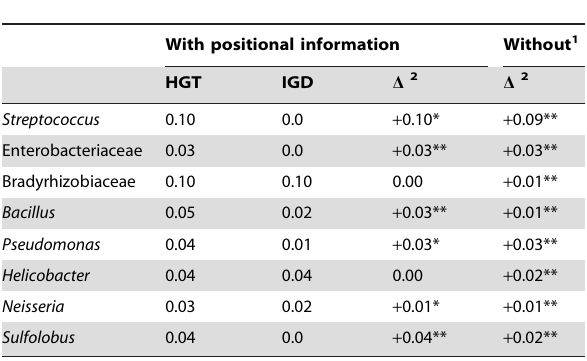
Table 2. Different ( D ) ages of IGD and HGT per clade.